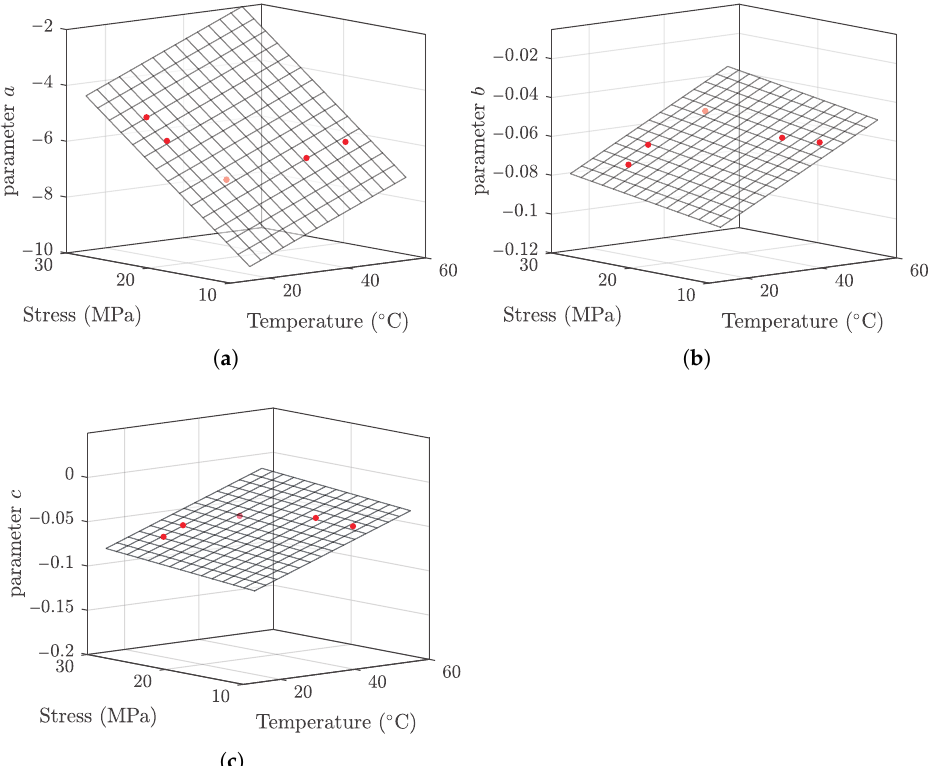
Figure 9. Temperature and stress dependence of parameters. ( a ) Parameter a , ( b ) parameter b , and ( c ) parameter c .